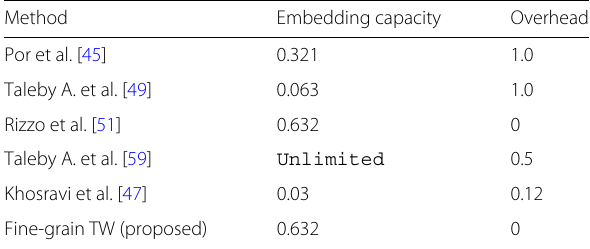
Table 4 Embedding capacity and overhead